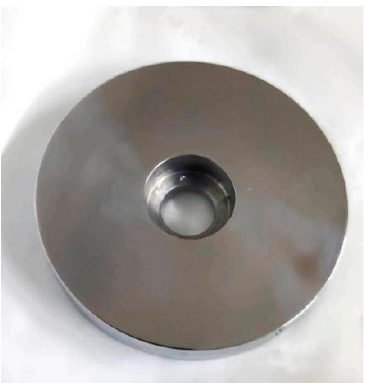
Figure 2. Brake disc sample.